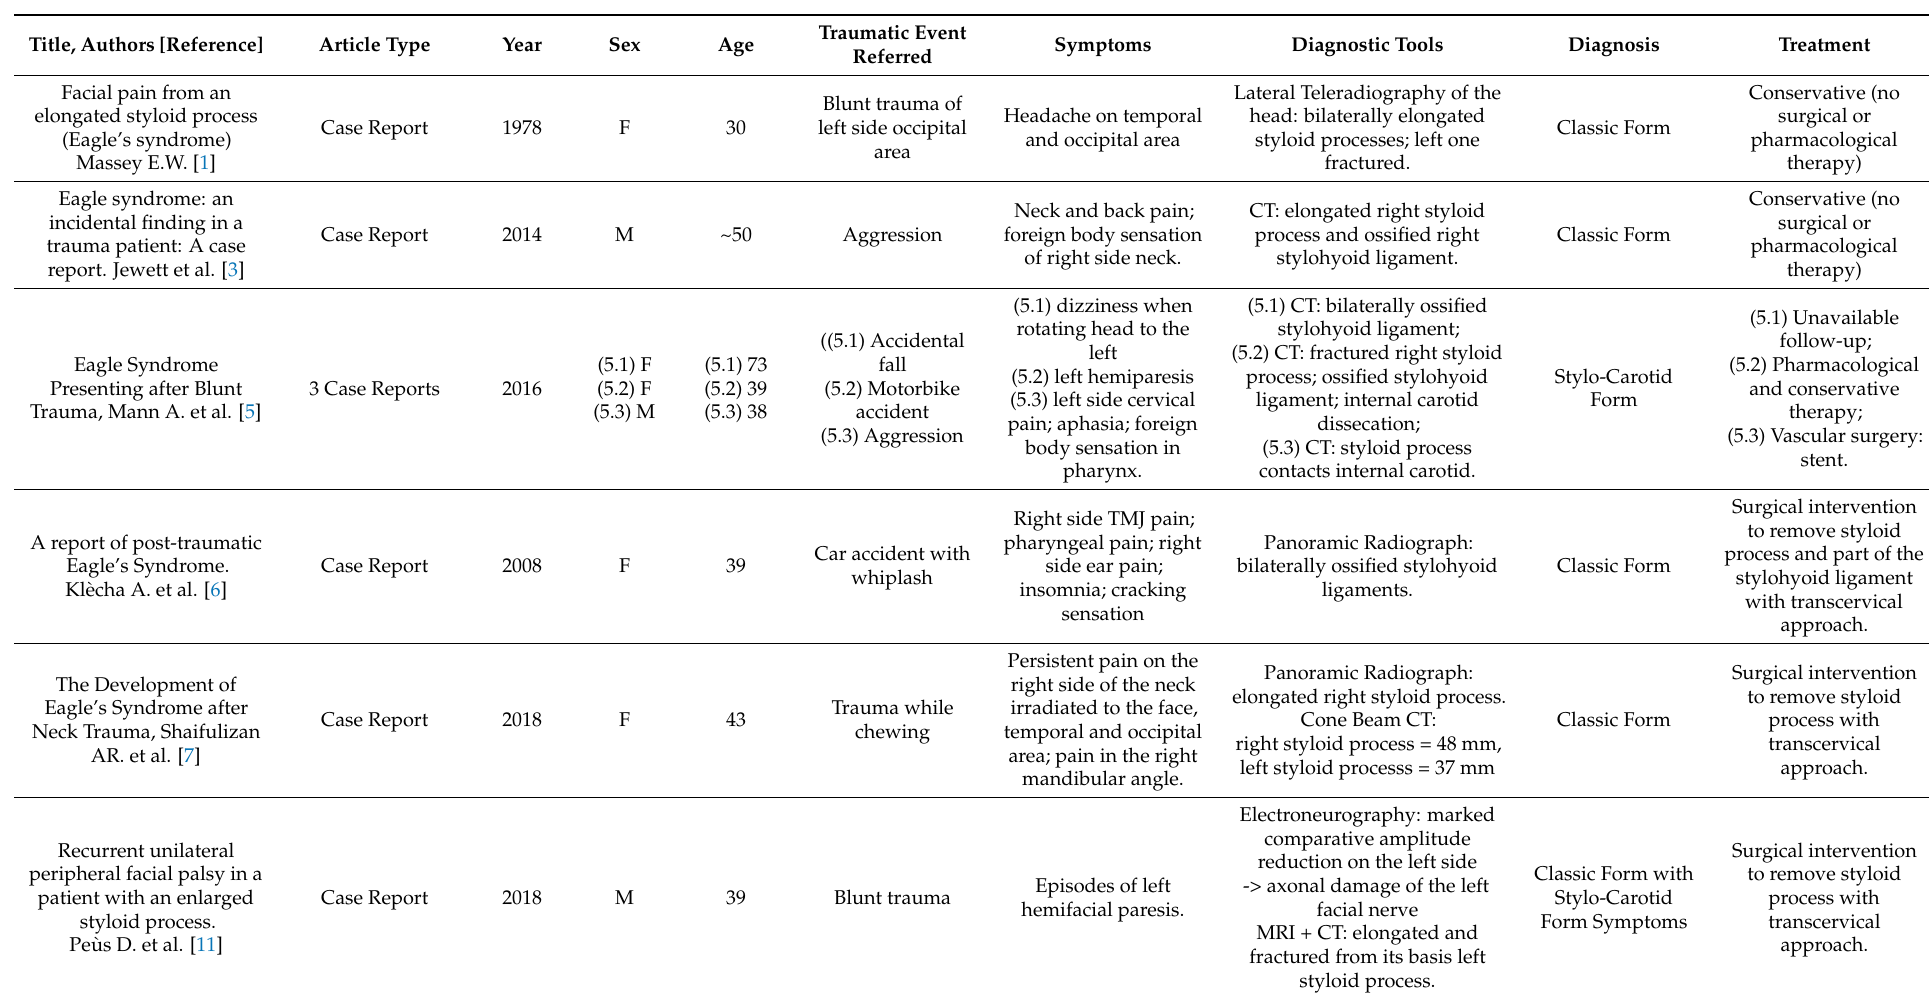
Table 2. Summarized correlation between Eagle Syndrome and traumatic